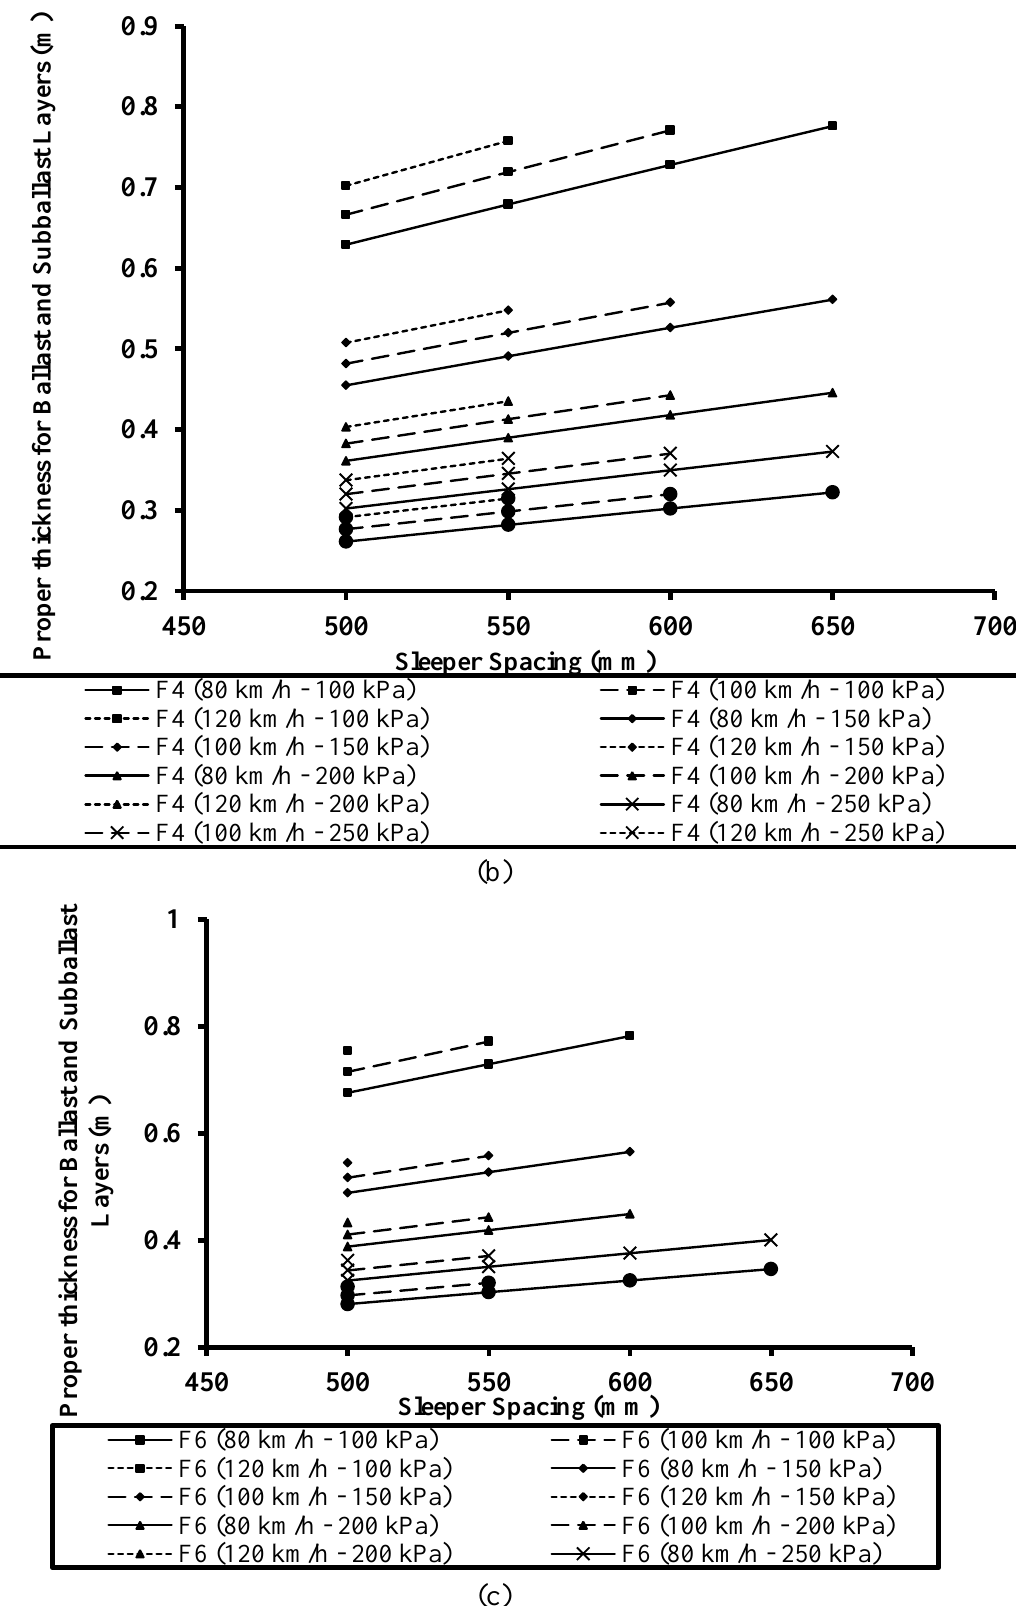
Fig. 11. Changes in the required thickness of the ballast and sub-ballast layers for a) passenger train, b) 4- axles freight train, c) 6- axles freight